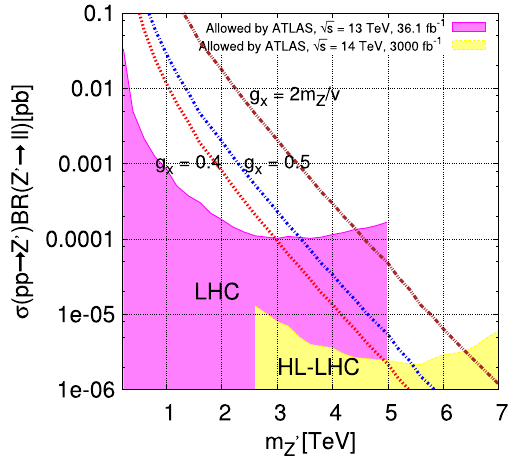
Fig. 2 σ Z (cid:2) B Z (cid:2) as a function of the Z (cid:2) gauge boson mass for g x = 0 . 4 , 0 . 5and2 m Z /υ. Dark areas correspond to allowed regions by ATLAS Collaboration [81]; magenta online corresponds to measure- ments at LHC and the yellow area represents a simulation for the HL- LHC [84]